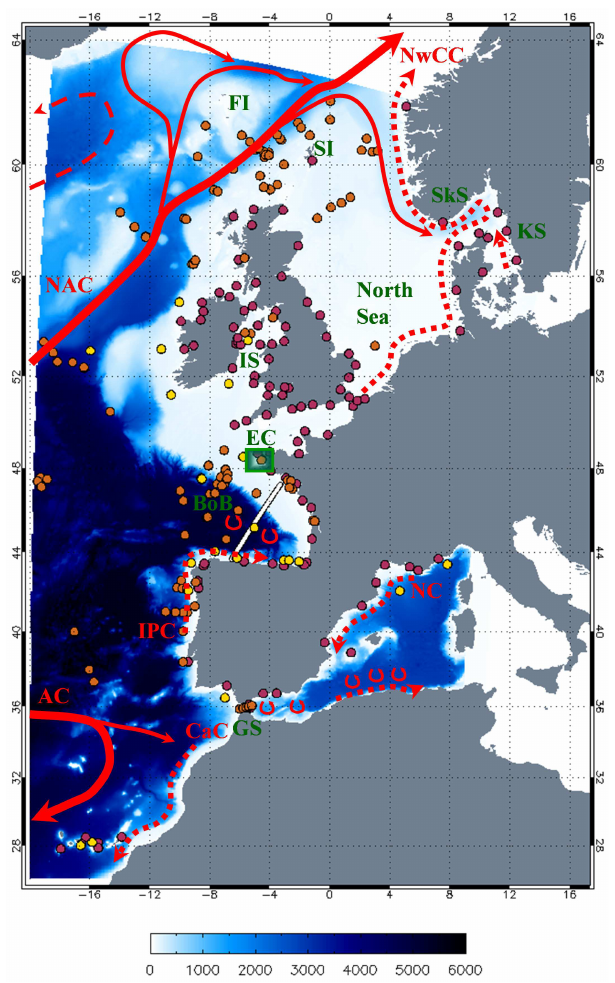
Fig. 1. Bathymetry of the domain (m). The black line indicates the 200m bathymetry contour. Superposed are the tide gauge positions (red dots), the buoy locations (yellow dots), the current-meter data for tidal comparisons (orange dots), the altimeter track crossing the Bay of Biscay (white line) and HF radar surface current measure- ments off West Brittany (green box). The main surface dynamical features are also shown: the Azores Current (AC), the Canary Cur- rent (CaC), the Northern Current (NC), the Iberian Poleward Cur- rent (IPC), the Norwegian Coastal Current (NwCC) the North At- lantic Current (NAC). Red symbols represent mesoscale activity in the Mediterranean Sea and in the Bay of Biscay. Some geograph- ical features of the area are also mentioned: the Strait of Gibraltar (GS), the Bay of Biscay (BoB), the English Channel (EC), the Irish Sea (IS), the Shetland Islands (SI) and the Faeroe Islands (FI), the Skagerrak Strait (SkS) and the Kattegat Strait